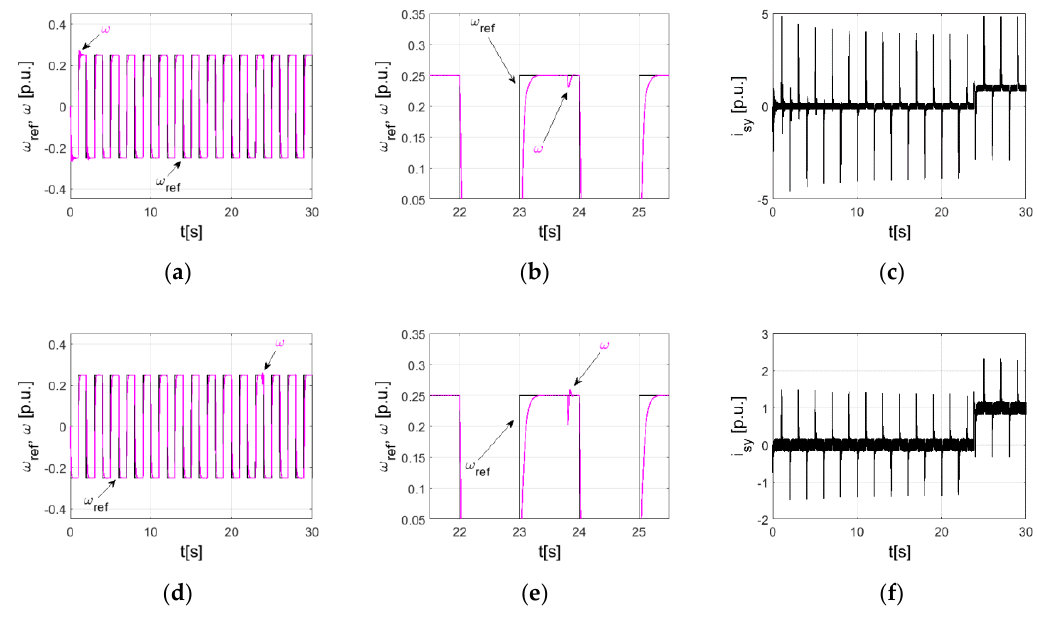
Figure 7. Transients of state variables (speed ω and current i sy ) in the Direct Field Oriented Control structure with neural speed controller - changes in the mechanical time constant: t m = 2 t mn ( a – c ); t m = 0.5 t mn ( d – f ).